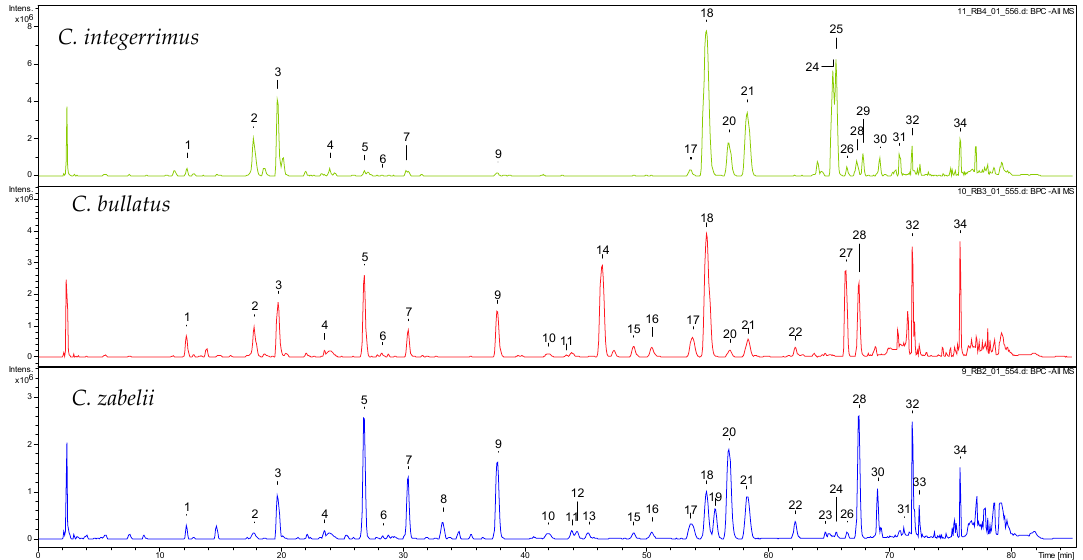
Figure 1. Representative total ion chromatograms (TIC) of the C. integerrimus , C. bullatus and C. zabelii leaf extracts recorded in the negative ion mode. The peak numbers of compounds refer to those used in Table 1.